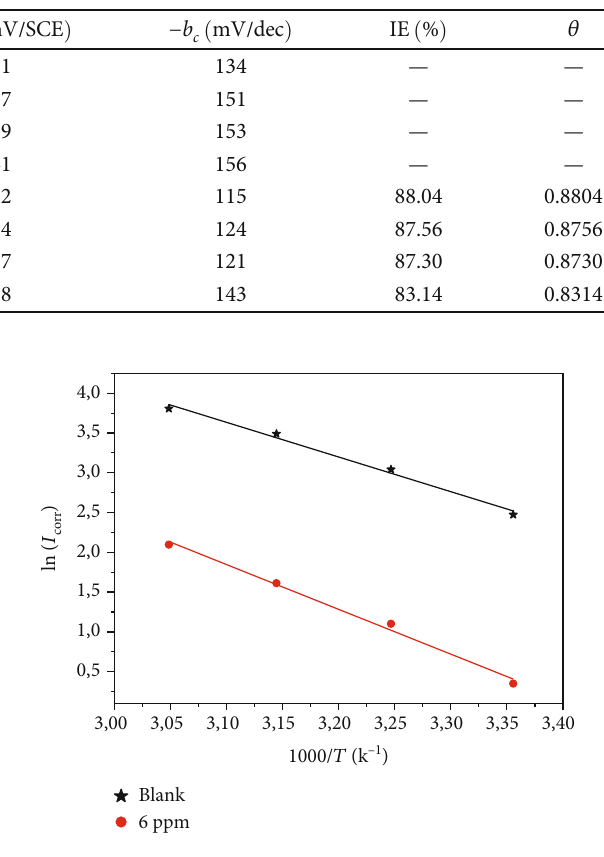
Figure 6: Arrhenius plots of AA3003 alloy in 1M HCl in the absence (black line) and presence (red line) of OMW at